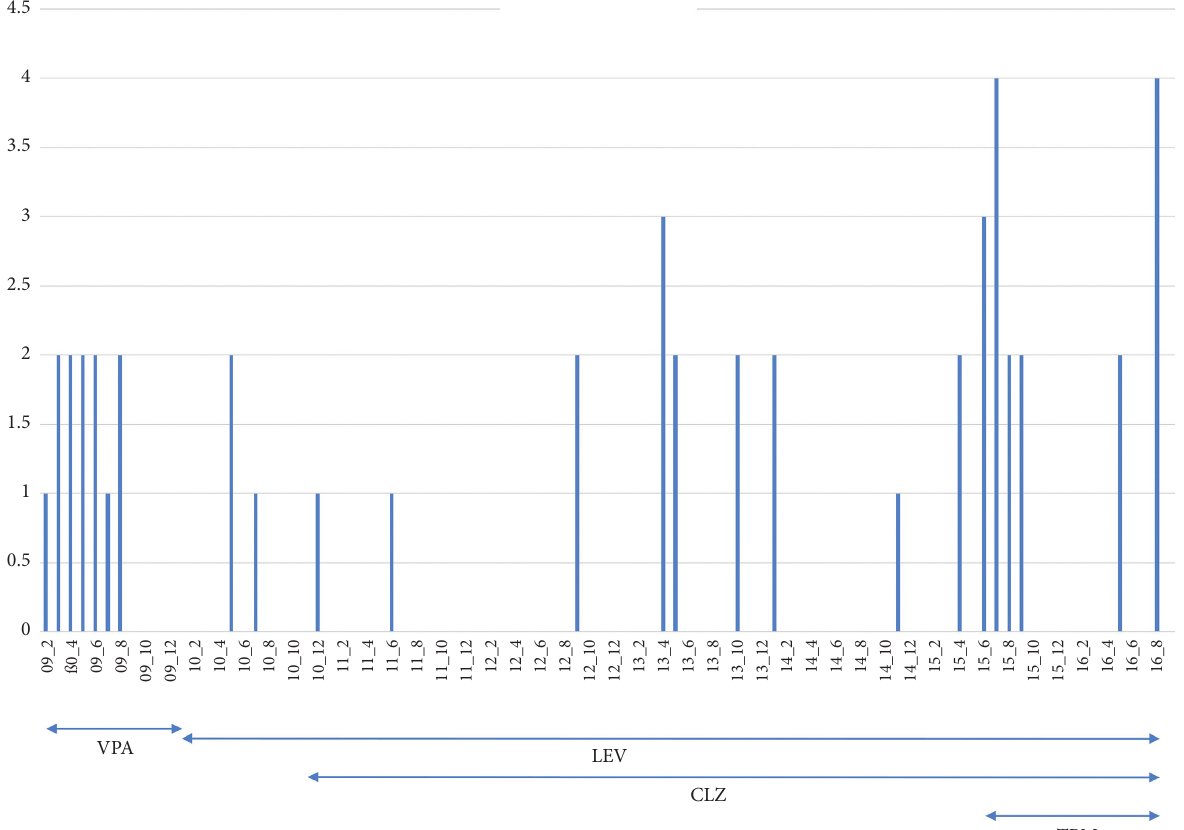
Figure 1: Frequency of focal and generalised seizures since onset at age 19y in the index patient (1): focal seizure, (2): one generalised seizure, (3): two generalised seizures, (4): three generalised seizures per